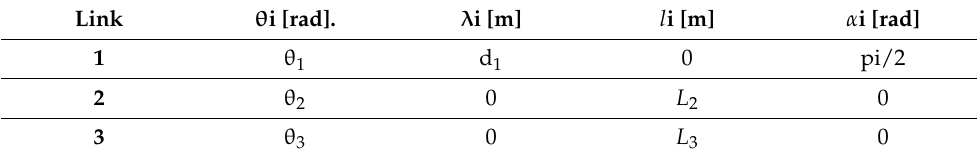
Table 2. Denavit-Hartemberg